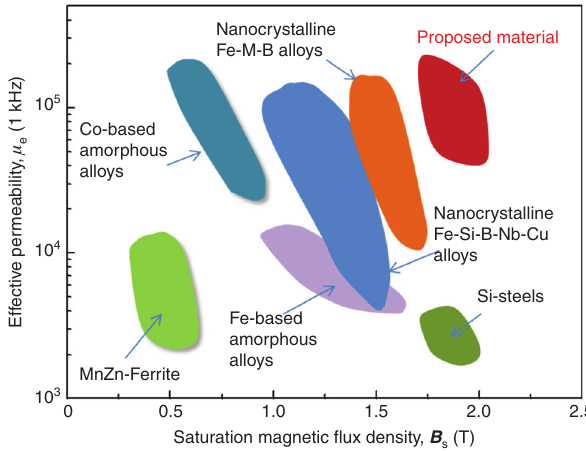
Figure 1 Typical magnetic property of soft magnetic materials.